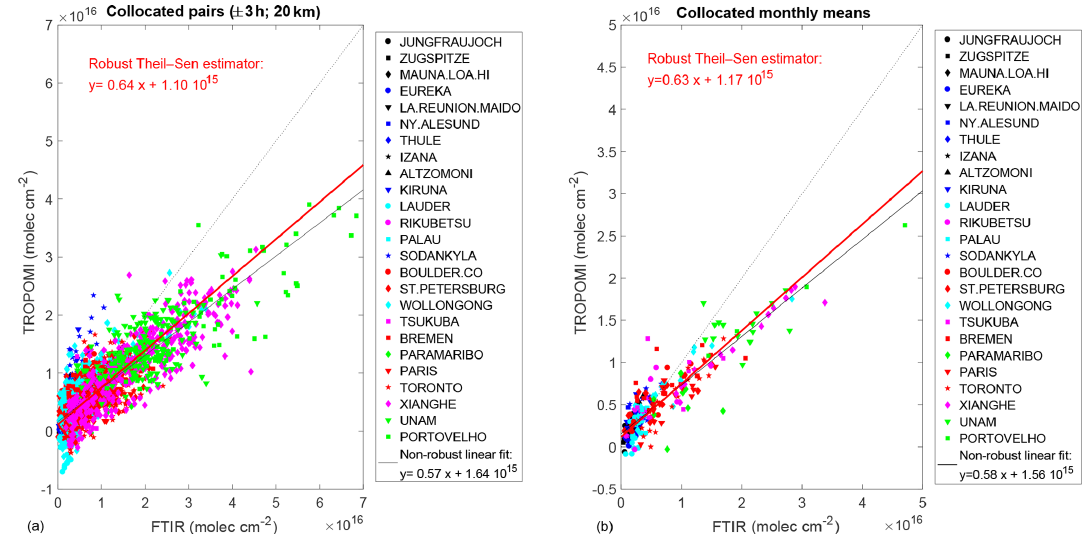
Figure 4. Scatter plots of TROPOMI versus FTIR data for individual collocated pairs ( ± 3h; a ), and for the monthly means of collocated data (b) . The non-robust OLS fit of the data is given in the legend and plotted as a black line, while the slope and intercept obtained with the robust Theil–Sen estimator are given by the red line and